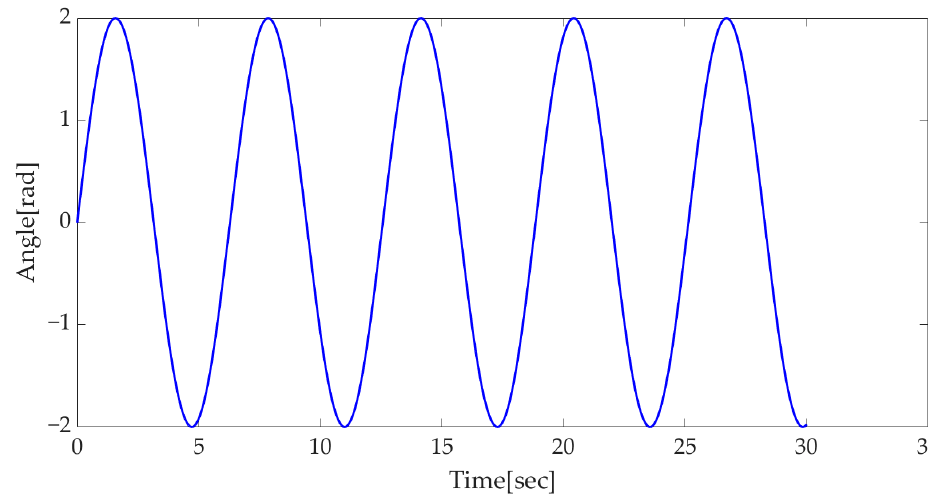
Figure 5. Continuous control input.